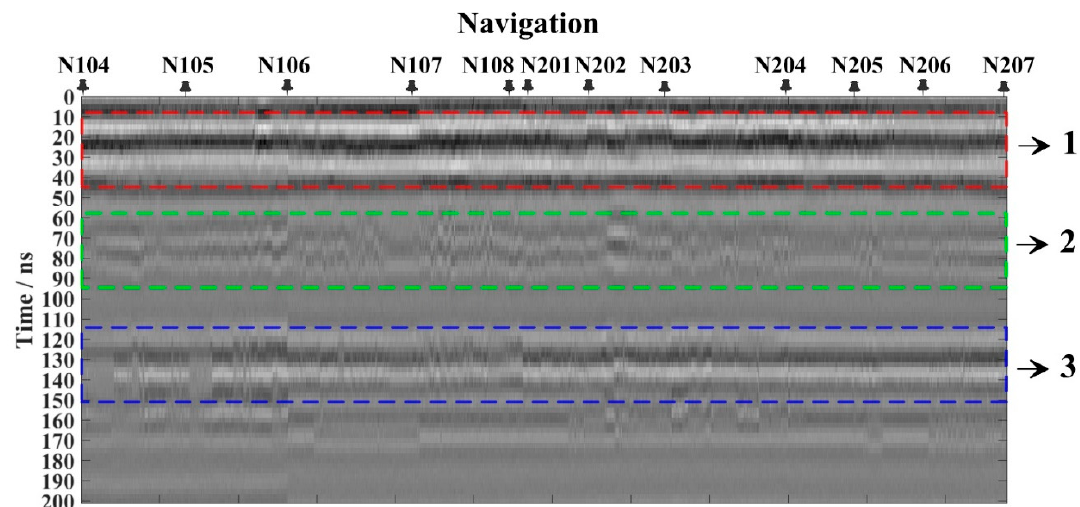
Figure 15. Stratification on CE-3 landing site by CH-1 data.